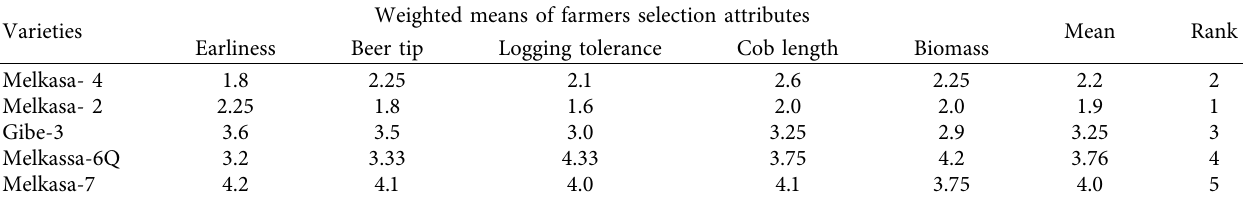
Table 9: Farmers’ preference ranking matrix summary sheet for OPV maize varieties in 2018. Weighted means of farmers selection Varieties